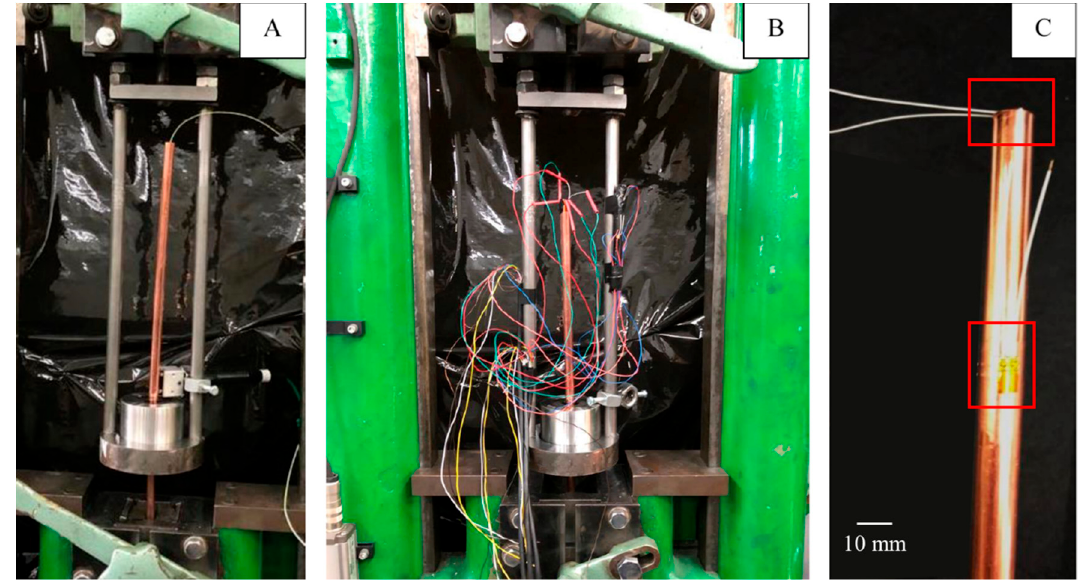
Figure 2. Test stands during the wire drawing process: ( A ) temperature verification with visible thermocouples; ( B ) elastic deformation analysis with visible strain gauges; ( C ) close-up of the sample with marked strain gauges (top—radial, bottom—axial in stationary conditions) .